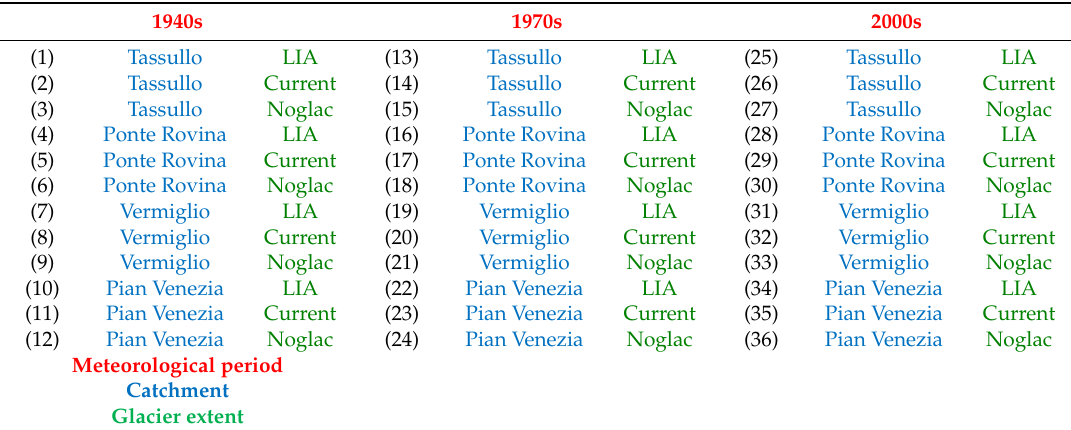
Table 3. Combinations of meteorological periods, catchments, and glacier extents tested in the sensitivity